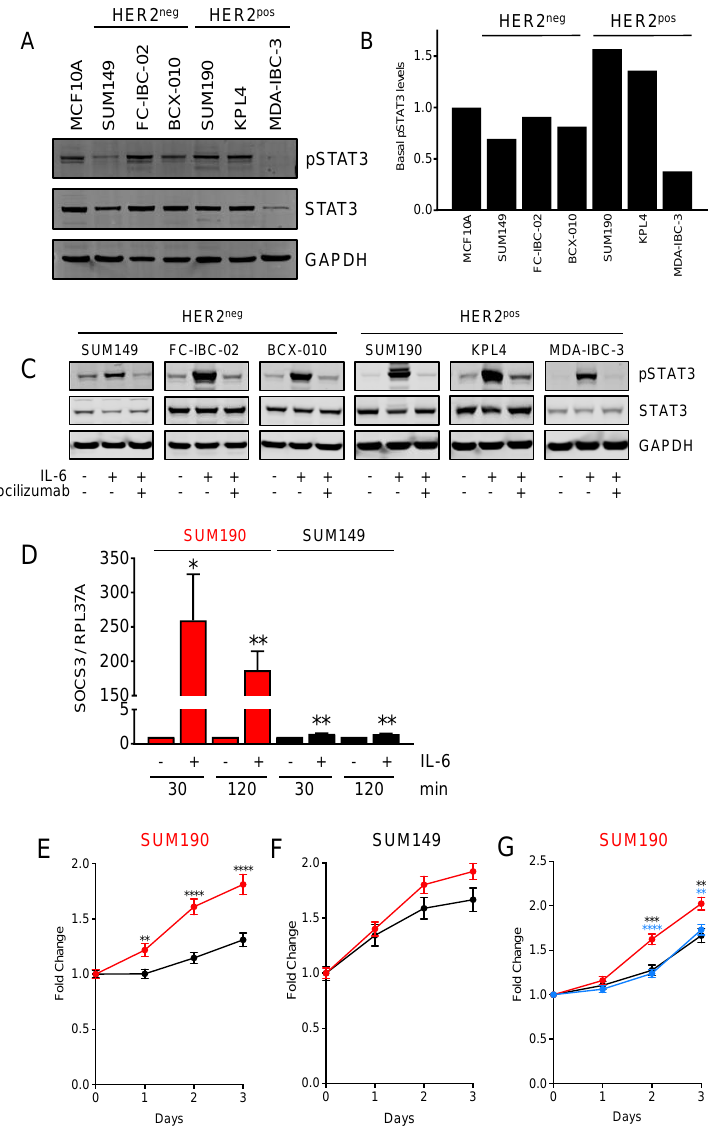
Figure 3. rhIL-6 induces STAT3 activation, induction of SOCS3 target gene, and cell proliferation in SUM190 HER2 pos IBC cells. ( A ) Basal pSTAT3 (Y705) levels were evaluated in MCF10A cells and IBC cell lines by Western blotting. Total STAT3 levels are also shown. GAPDH was used as a loading control. pSTAT3 was detected all six cell lines. ( B ) Quantification of pSTAT3 levels using densitometry. pSTAT3 levels were normalized to total STAT3 and GAPDH levels. pSTAT3 levels in MCF10A cells were set to 1. ( C ) rhIL-6 induced STAT3 activation was determined in IBC cell lines (three HER2 neg , three HER2 pos ) by Western blotting. Cells were stimulated with vehicle or rhIL-6 (50 ng/mL) for 30 min or pre-treated with anti-IL-6R antibody Tocilizumab (50 µg/mL) for 1 h prior to rhIL-6 exposure (50 ng/mL, 30 min). Total STAT3 levels are also shown. GAPDH was used as a loading control. ( D ) SOCS3 mRNA levels were determined by TaqMan qRT-PCR in SUM190 cells or SUM149 cells following stimulation with rhIL-6 (50 ng/mL) or vehicle (-) for 30 or 120 min. Ex- pression in vehicle treated cells was set to 1. Mean ± SD of 3 biological replicates is shown. * p < 0.05, ** p < 0.01. ( E ) SUM190 cell number was determined either in serum-free conditions (black line) or following exposure to rhIL-6 (red line, 50 ng/mL). ** p < 0.01, **** p < 0.0001. ( F ) SUM149 cell number was determined either in serum-free conditions (black line) or following exposure to rhIL-6 (red line, 50 ng/mL). ( G ) SUM190 cell number was determined either in serum-free conditions (black line), following exposure to rhIL-6 (red line, 50 ng/mL), or following Tocilizumab (50 µg/mL) plus rhIL-6 (50 ng/mL) exposure (blue line). Cell number was set to 1 at day 0. ** p < 0.01, *** p < 0.001, **** p < 0.0001. All proliferation assays shown mean ± SEM ( n = 3). p -values were calculated using unpaired Student’s t test.